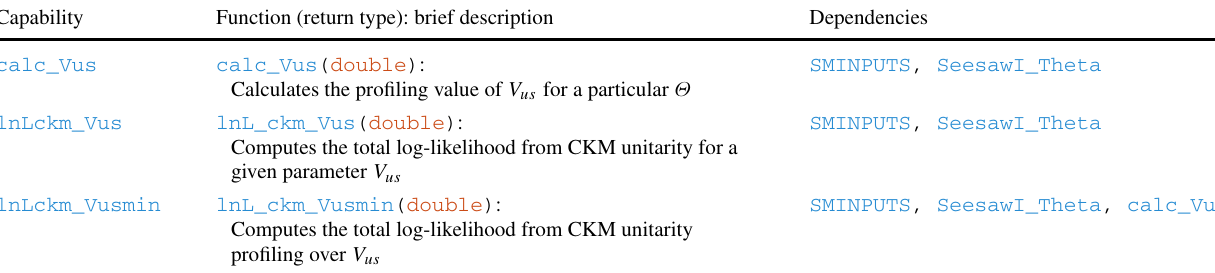
Table 15 Capabilities and module functions implemented to calculate CKM unitarity and its likelihood Capability